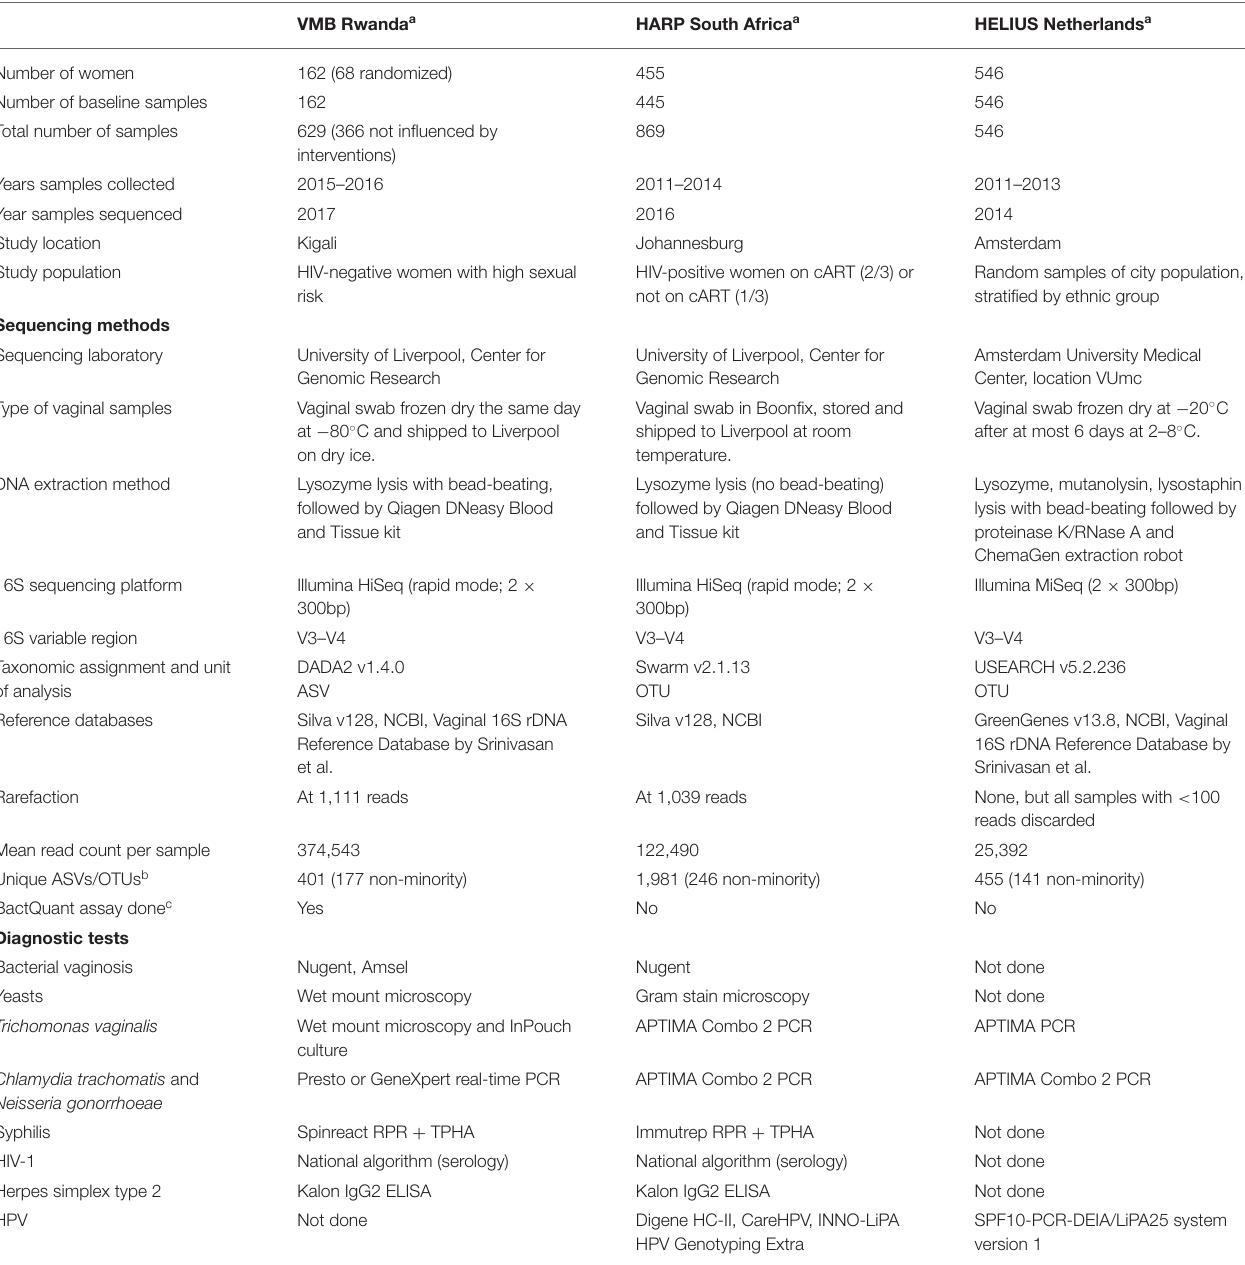
TABLE 1 | Main study characteristics of the three